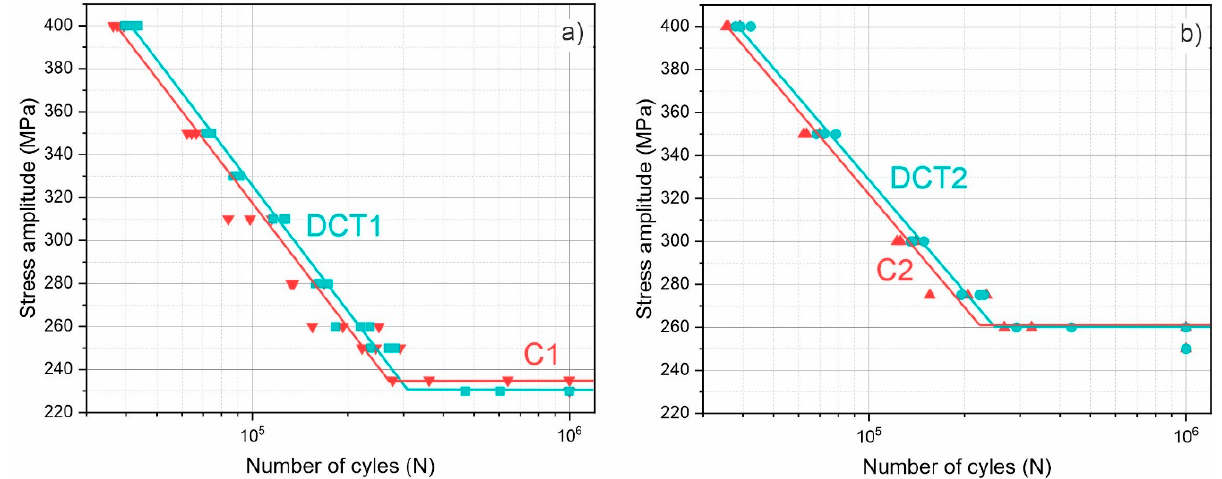
Figure 7. Fatigue test results for heat treatments with higher/lower solution annealing temperature (1080 °C/1000 °C) for ( a ) C1/DCT1 groups and ( b ) C2/DCT2 groups accordingly, where C1/C2 are conventional solution annealing subgroups, and DCT1/DCT2 are deep cryogenically treated.